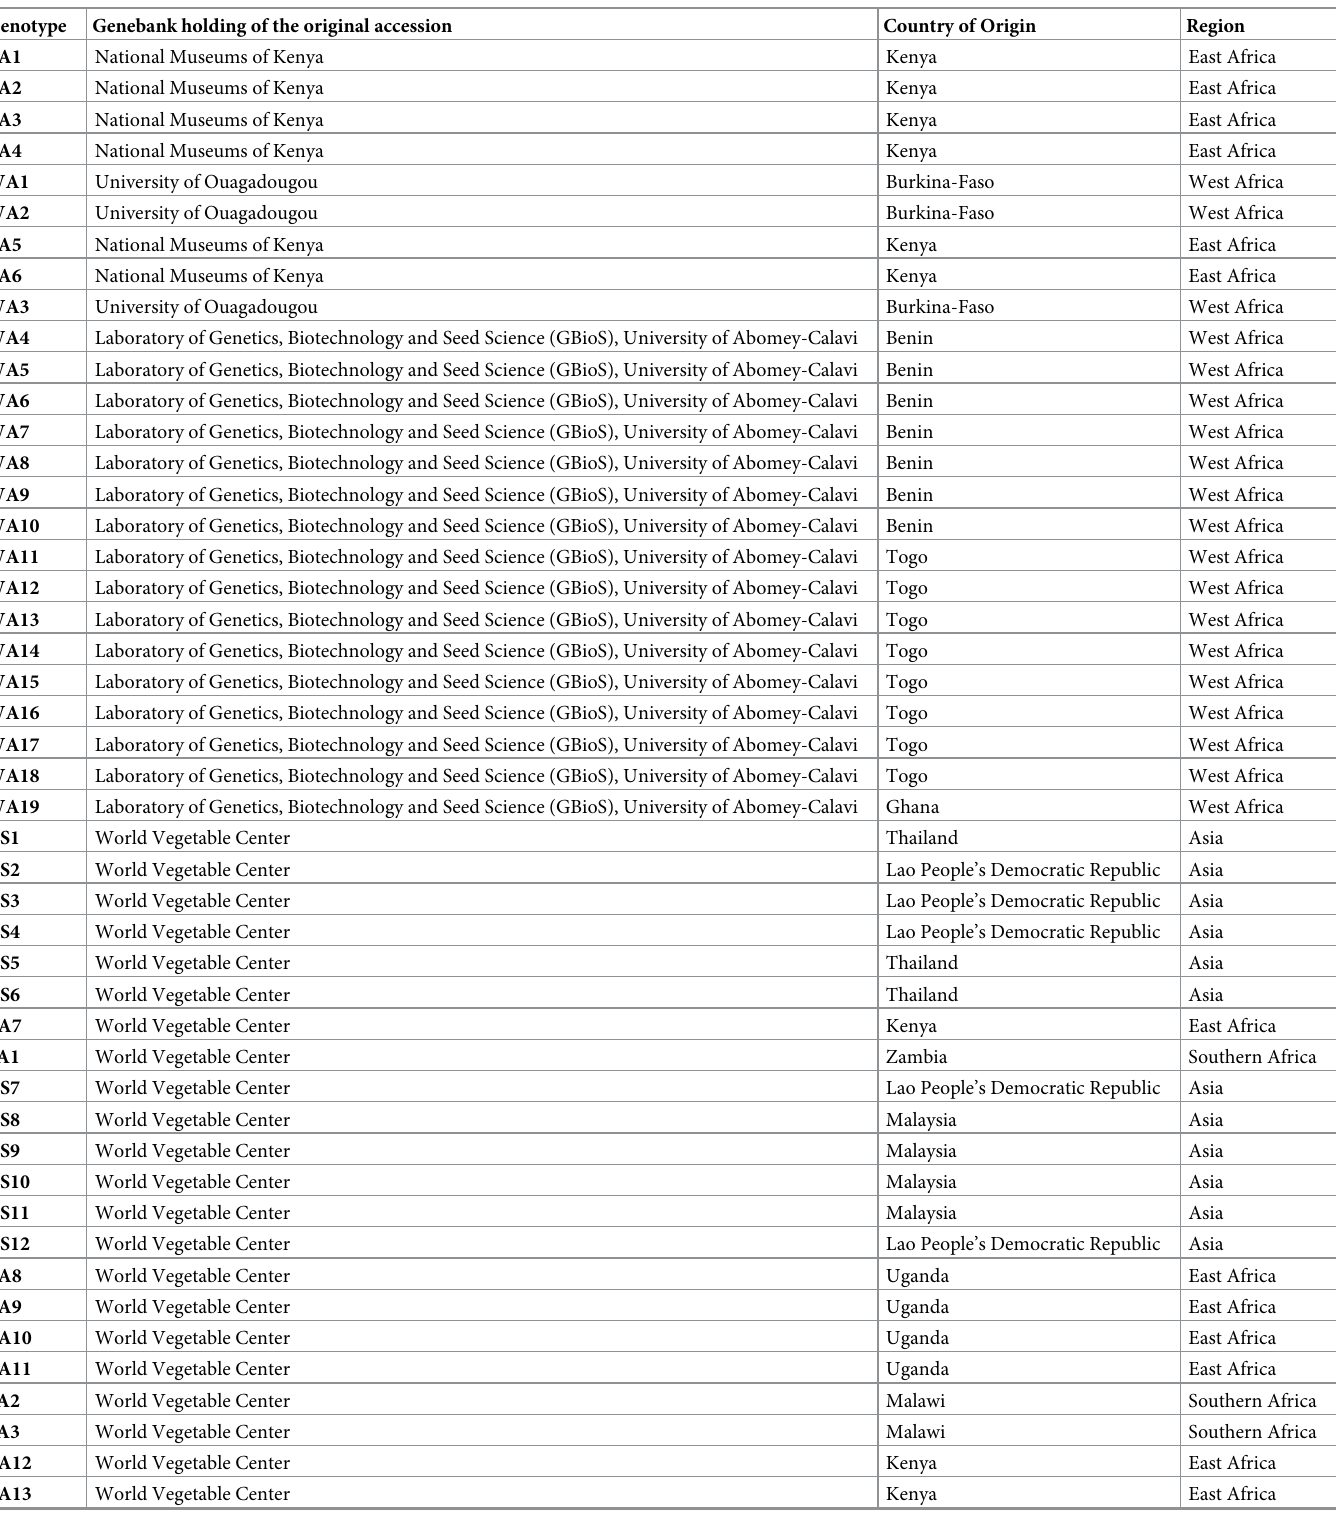
Table 1. List of advanced lines of Gynandropsis gynandra used in this study and their origin.